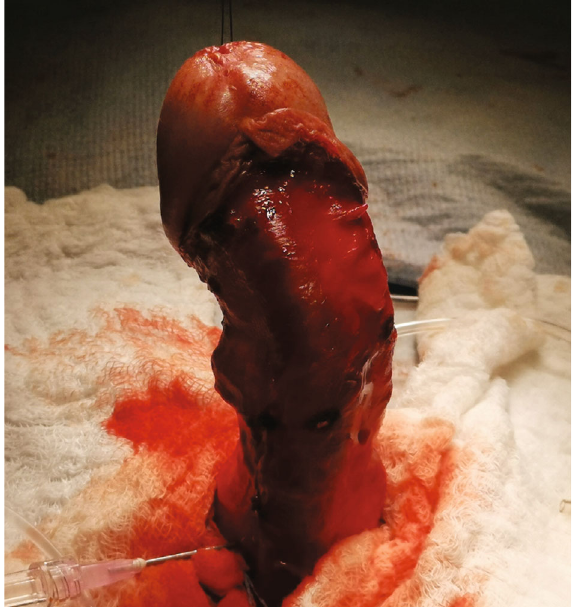
Figure 8: Angulation and rotation of penis at arti fi cial erection before surgical correction (Drlik [8]).